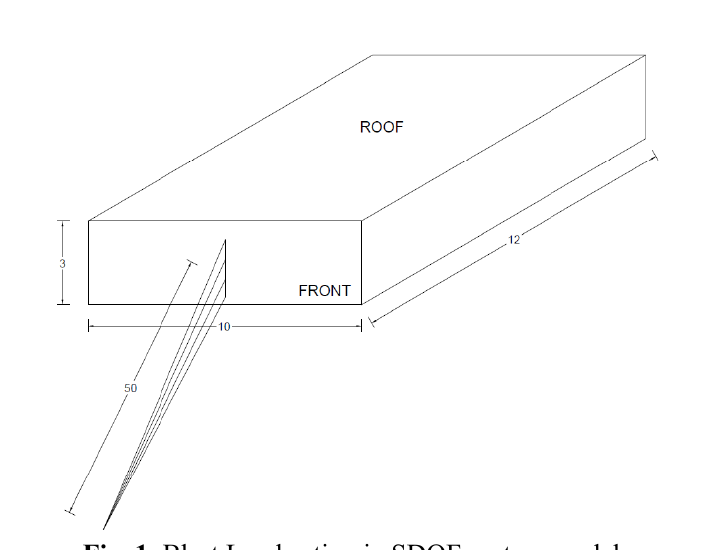
Fig. 1. Blast Load acting in SDOF system